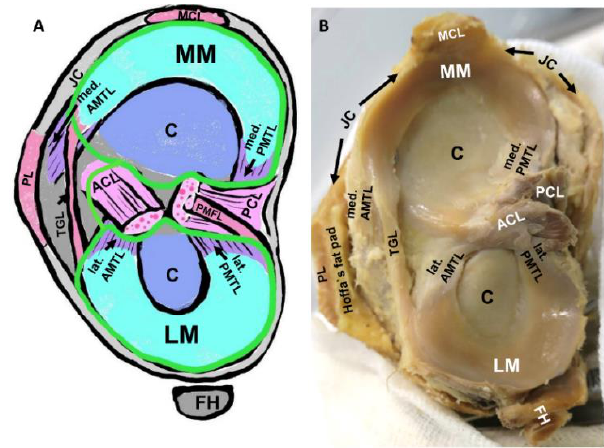
Figure 2. Intraarticular meniscotibial ligaments. ( A ): Schematic view on the tibial plateau. ( B ): Human gross anatomy of the tibial plateau with menisci and meniscotibial ligaments. ACL: anterior cruciate ligament, AMTL: anterior meniscotibial ligament, C: joint cartilage, FH: fibular head (in B covered by the popliteus muscle and the lateral collateral ligament), JC: joint capsule (gray), LM: lateral meniscus, MCL: medial collateral ligament, MM: medial meniscus, PCL: posterior cruciate ligament, PMFL: posterior meniscofemoral ligament, PMTL: posterior meniscotibial ligament, TGL: transverse genicular ligament. Green line: synovial membrane.